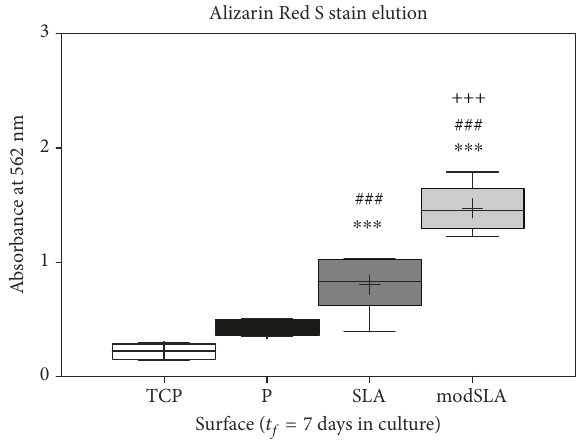
Figure 7: Assessment of osteogenic mineralisation with Alizarin Red S elution and spectrophotometry revealed rough Ti surfaces had induced signi fi cantly higher levels of calcium deposition by this time with the hydrophilic modSLA surface inducing signi fi cantly higher levels of calcium deposition than hydrophobic SLA. Box and whisker plot with minimum to maximum readings, N = 1 ; n = 3 . ∗∗∗ p < 0 001 , TCP vs. any Ti. ### p < 0 001 , P vs. rough. +++ p < 0 001 , SLA vs.